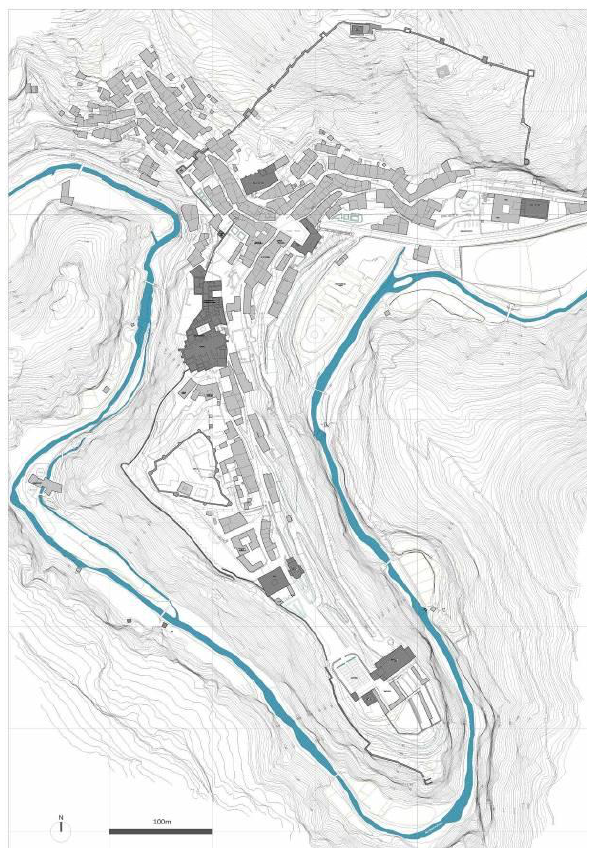
Figure 1. Plan of Albarracín (Díaz, 2014 from Almagro,